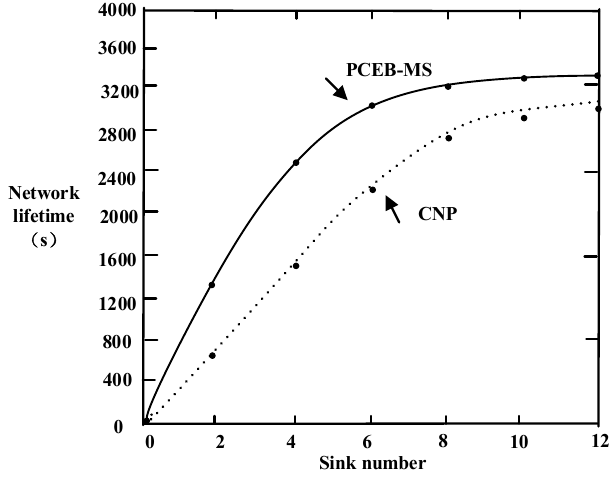
Figure 12. Comparison of network lifetime with different numbers of sinks.